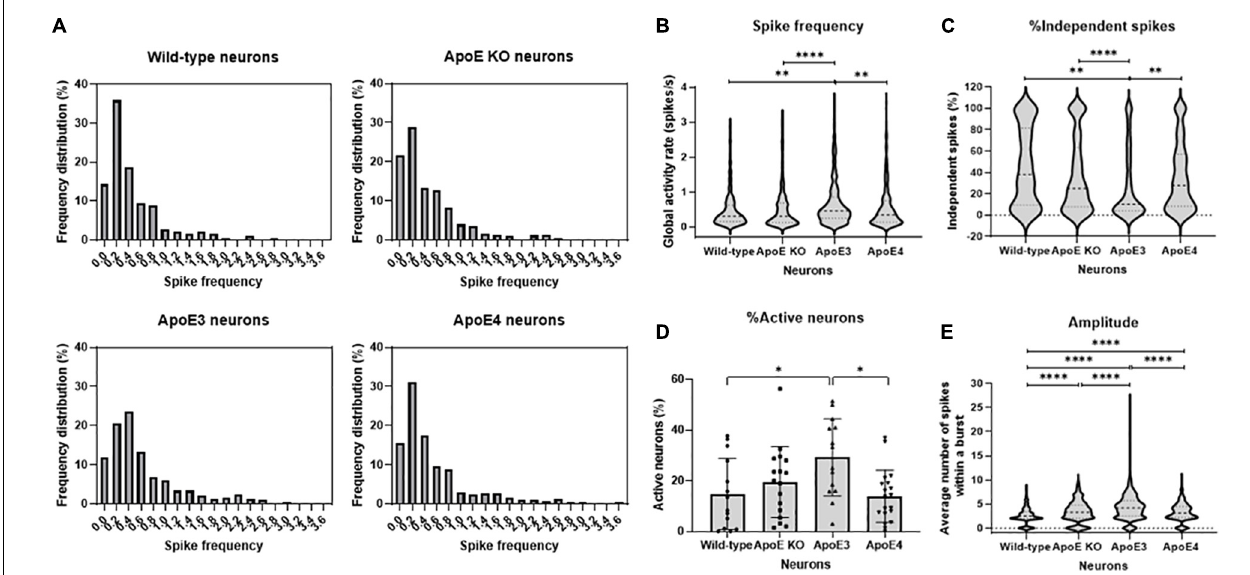
FIGURE 4 | ApoE3 neurons show increased neuronal activity compared to wild-type, ApoE KO and ApoE4 neurons. (A) Representative frequency distribution graphs of wild-type, ApoE KO, ApoE3 and ApoE4 neurons (18–20 DIV) obtained using live cell Ca 2 + imaging. (B–E) Quantifications of spike frequency (B) , percentage of independent spikes within a neuron culture (C) , percentage of active neurons, i.e., more than 2 spikes per 2 min, within a culture (D) , and amplitude (E) in wild-type, ApoE KO, ApoE3 and ApoE4 neurons ( N wild − type = 14 embryos, N ApoEKO = 17 embryos, N ApoE 3 = 14 embryos, N ApoE 4 = 19 embryos; n wild − type = 181 neurons, n ApoEKO = 432 neurons, n ApoE 3 = 474 neurons, n ApoE 4 = 327 neurons). Data are expressed as violin plots (B,C,E) or mean ± SD (D) . Statistical analyses were performed using Kruskal-Wallis tests, followed by Dunn’s tests. * p < 0.05; ** p < 0.01; *** p < 0.001; **** p <